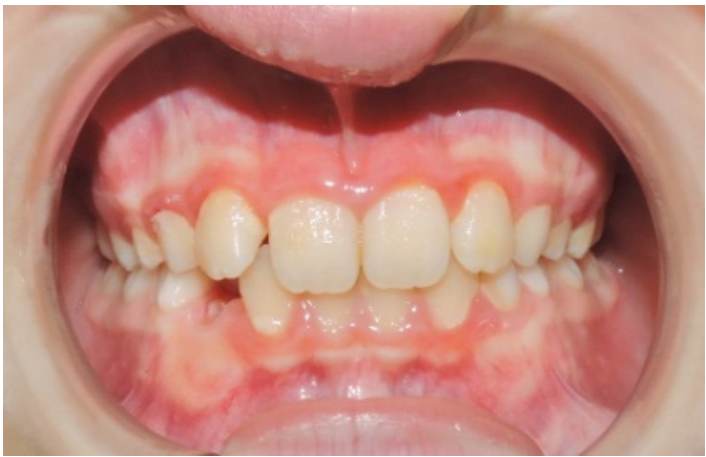
Figure A4. Occlusion of patient L.C.